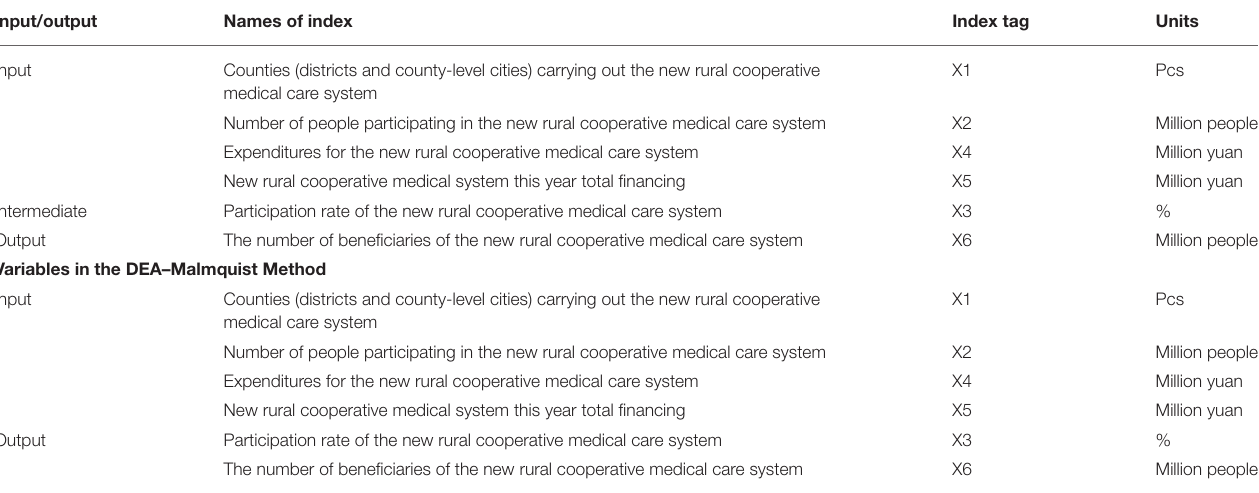
TABLE 2 | Variables in the two-stage network DEA.